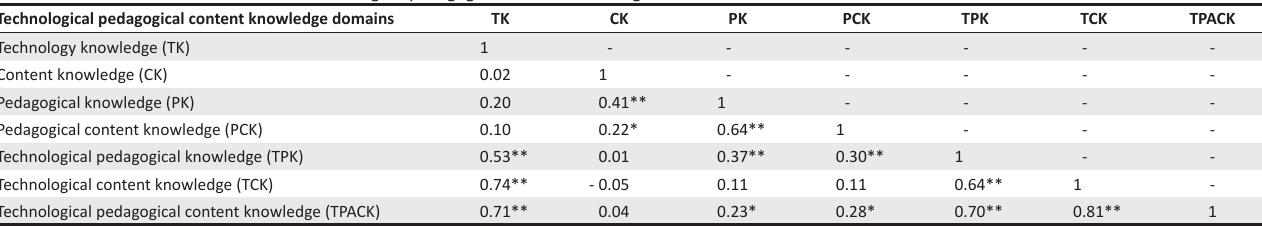
TABLE 5: Correlations table of the seven technological pedagogical content knowledge domains. Technological pedagogical content knowledge domains